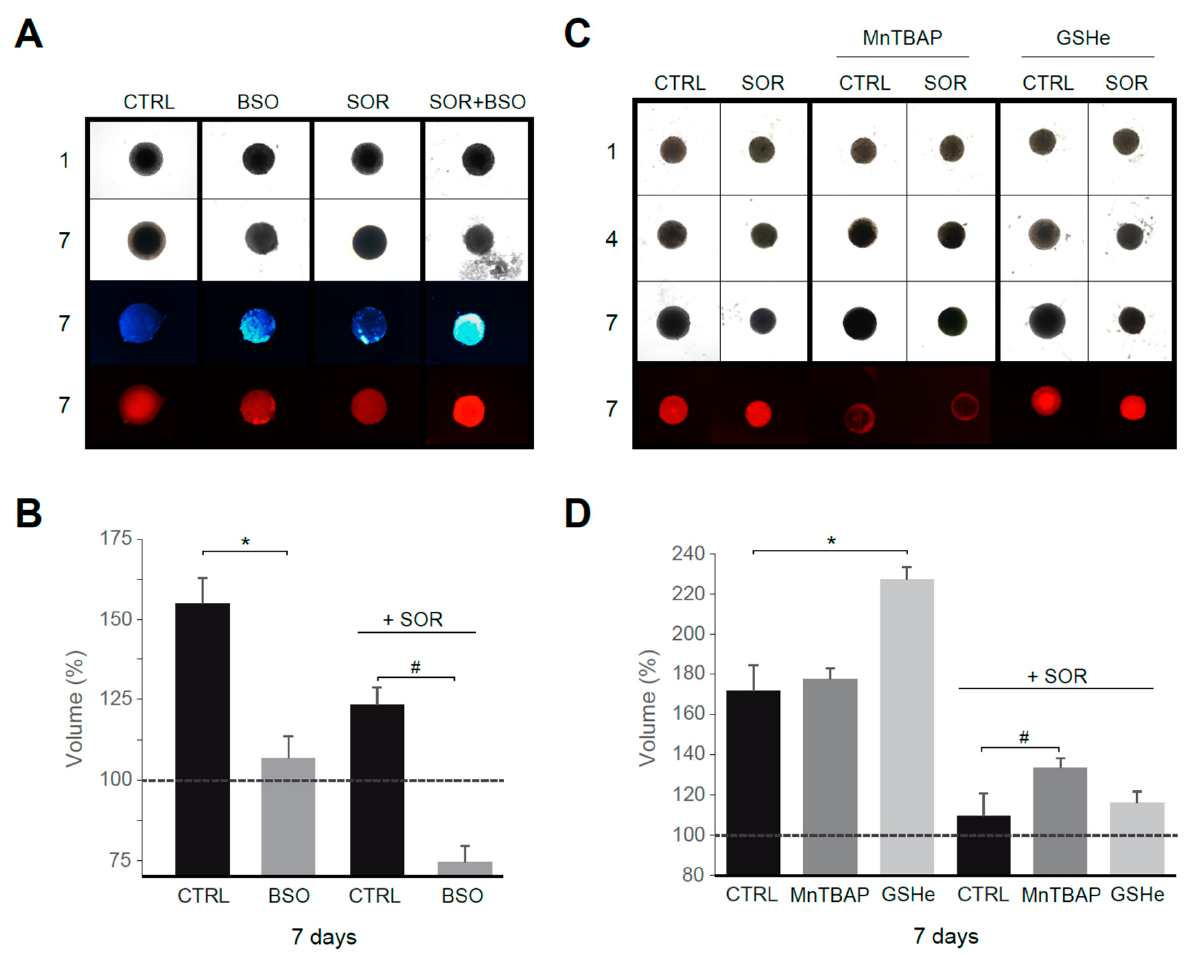
Figure 6. Superoxide reduction in sorafenib treatment favors tumor growth in a 3D spheroid model. ( A ) Hep3B spheroids were seeded (day 1) and treated with vehicle, sorafenib (S, 2.5 µM) and/or BSO (1 mM) for six days. Third row, Hoechst staining. Fourth row, DHE staining. ( B ) Spheroid growth was monitored ( n = 3). ( C ) Effect of MnTBAP and GSHe on spheroid growth ( n = 3). ( D ) Volume quantification. * p < 0.05 vs. control cells, # p < 0.05 vs. sorafenib-treated cells.